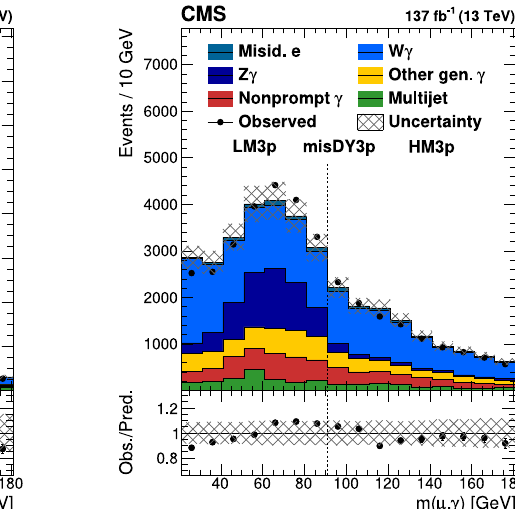
Figure 4 . Distribution of the invariant mass of the lepton and the photon, m ( ‘, γ ) , in the N = 0 selection for the e channel (left) and the m channel (right). The genuine photon contributions N b of W γ and Z γ are visualized separately. The lower panels show the ratio of the observed to the predicted event yields. The pre-fit systematic uncertainties are shown as a hatched